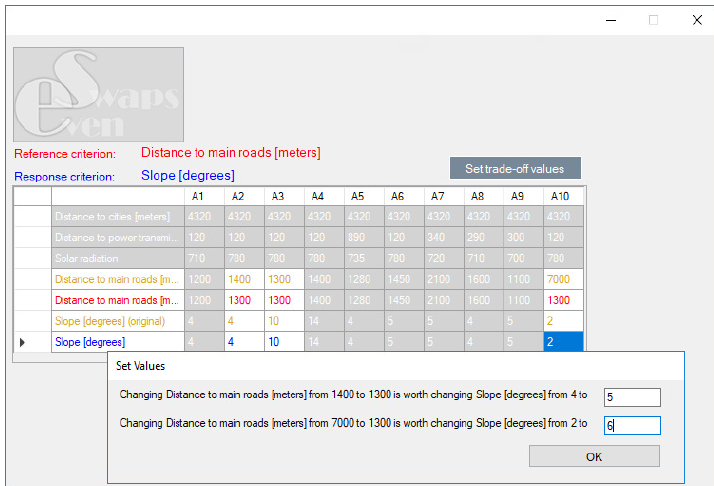
Figure 11. The status after three of the criteria were previously dismissed from further process and seven dominated alternatives were removed. In the current step, Distance to main roads is chosen as the reference criterion, and Slope is chosen as the response criterion. The values in terms of the response criterion need to be adjusted in order to compensate for the adjustments needed to render all three remaining alternatives equal (at the value of 1300) in terms of the reference criterion. This is done by increasing the value in terms of Slope from four to five degrees for alternative A2, and from two to six degrees for alternative A10. After this swap is performed, the reference criterion, Distance to main roads , will be dismissed. The values in terms of the only remaining criterion, Slope , will be five degrees for A2, ten degrees for A3, and six degrees for A10. A2 is chosen as the most preferred alternative, as it has the best value on the only remaining